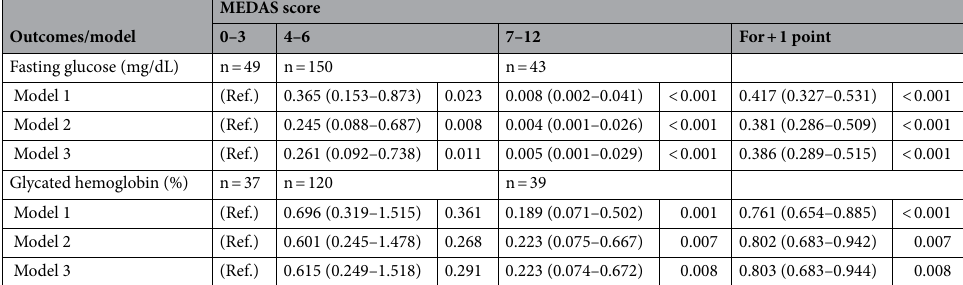
Table 2. Multivariable-adjusted odds ratios (95% confidence intervals) from logistic regression for abnormal blood glucose level by MEDAS score. Model 1 unadjusted, Model 2 adjusted for gender, age, BMI, Model 3 additionally adjusted for nutrient intake, MEDAS Mediterranean diet adherence screener.